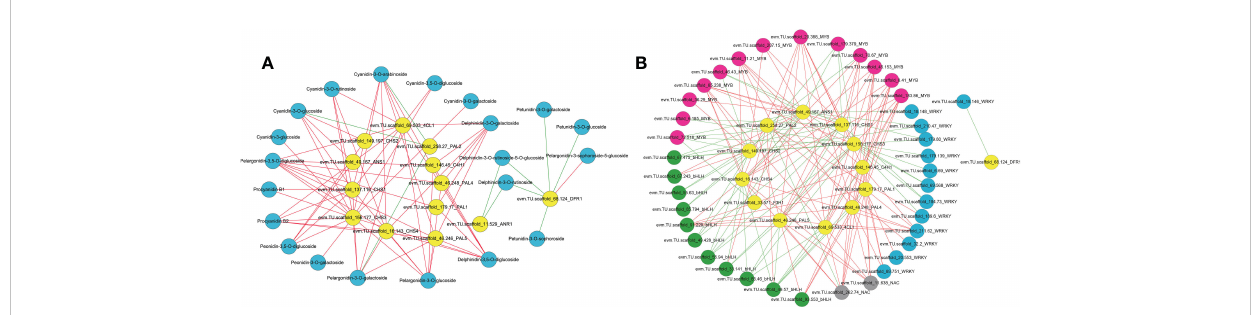
FIGURE 5 Correlation network analysis of anthocyanin structural genes with anthocyanin components, MYB, bHLH, WRKY and NAC TFs in the sepal of Heptacodium miconioides . (A) Interaction network between selected genes and anthocyanins. (B) Interaction network between selected genes and candidate transcription factors. The red line indicates a positive correlation and the green line indicates a negative